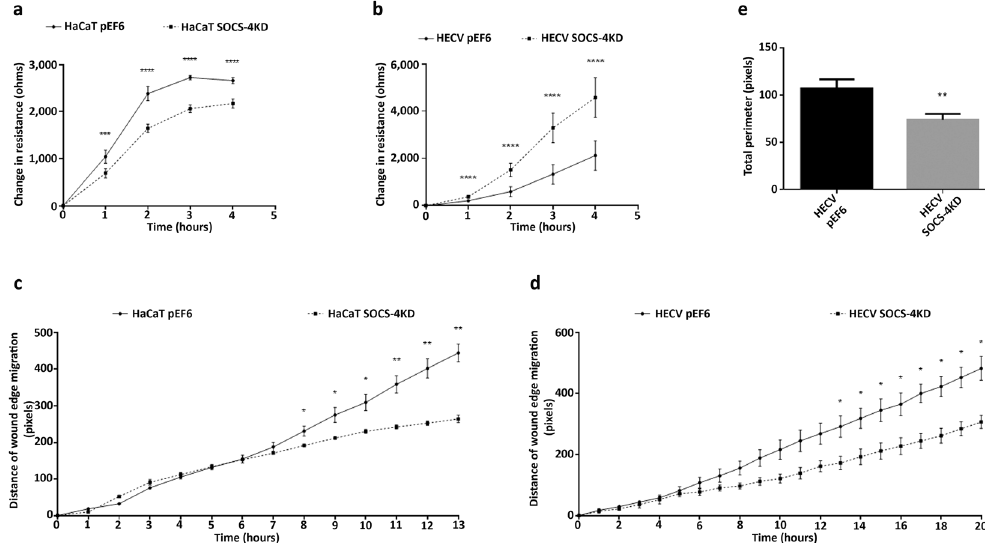
Figure 4. Impact of SOCS-4 knockdown on cellular migration and tubule formation. Cellular migration was assessed using an ECIS model in ( a ) HaCaT and ( b ) HECV cells following SOCS-4 knockdown. Mean change in resistance following monolayer wounding was detected by the ECIS system and was used to quantify cell migration. Cellular migration was also explored using a conventional scratch wound assay, monitored by the EVOS system, in ( c ) HaCaT and ( d ) HECV cells following SOCS-4 knockdown. Angiogenic potential was assessed, following SOCS-4 knockdown in HECV cells using a Matrigel tubule formation assay ( e ). Data shown is representative of a minimum of three repeats, error bars represent standard deviation (a/b/e) and standard error of the mean (c/d), * represents p < 0.05, ** represents p < 0.01, *** represents p < 0.001 and **** represents p < 0.0001.